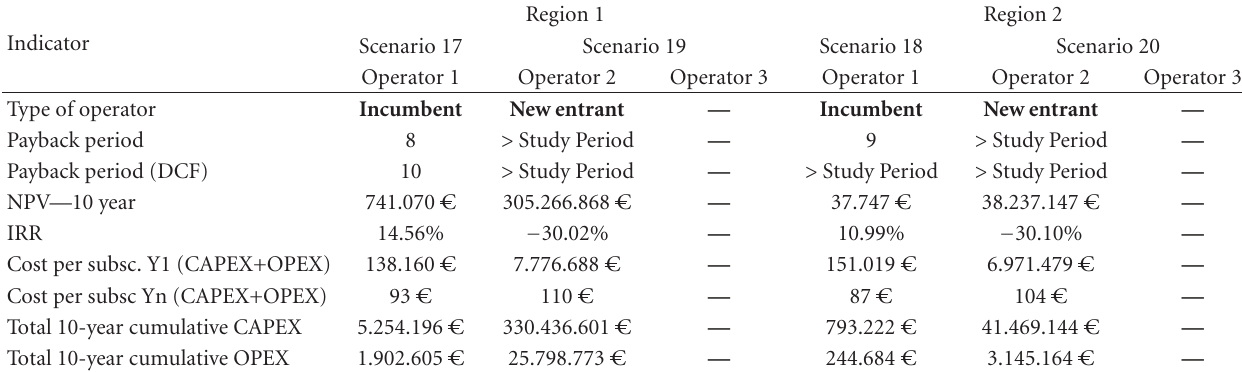
Table 14: General economic results of